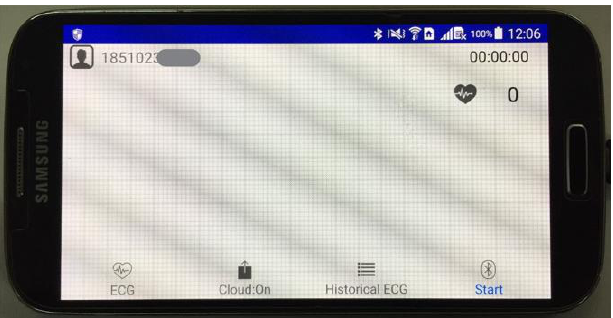
Figure 5. The main user interface of the Android APP.